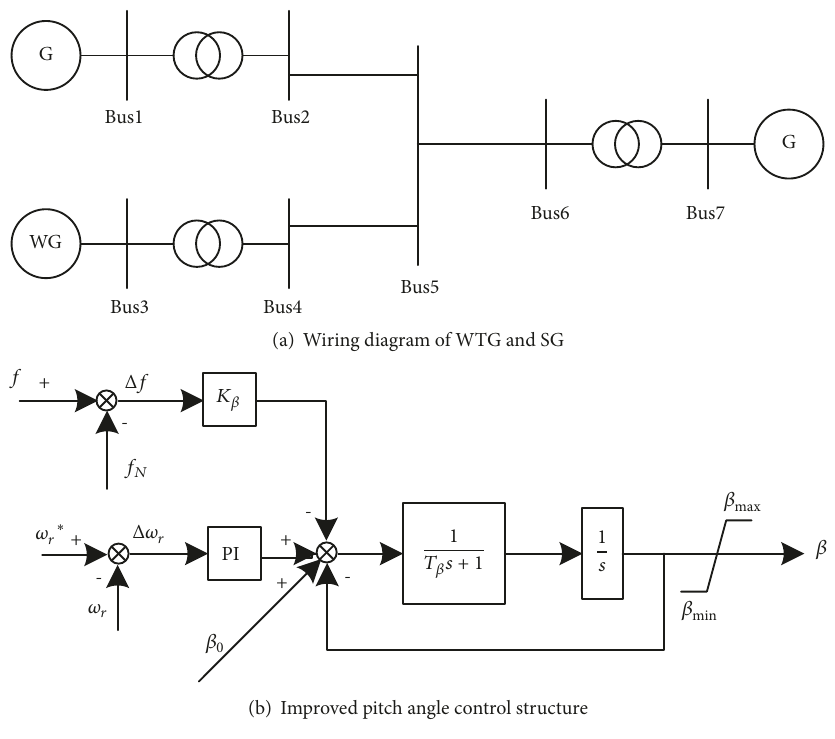
Figure 1: Structure of power system including wind turbines and main controller.